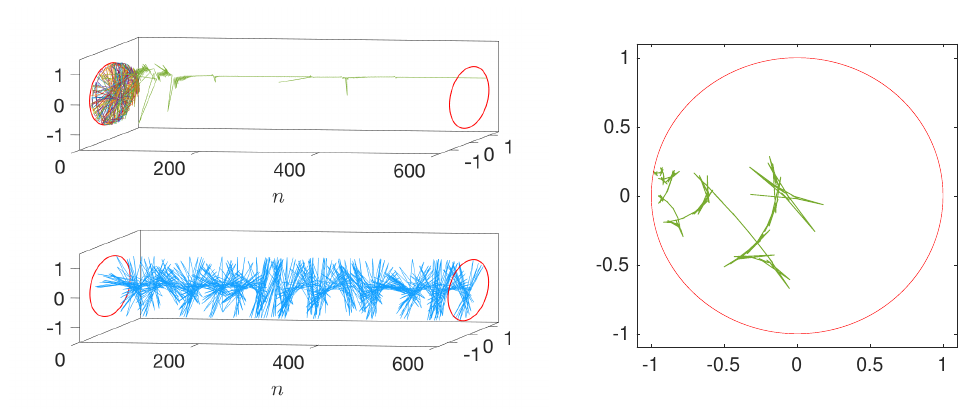
2 π xn Figure 22: Left (top): Trajectories of operator evolution ( e i l ) in a single random driving sequence. We choose 20 different initial positions homogeneously distributed 2 π x peak on the circle. Left (bottom): The trajectory of energy density peaks e i l in a = 0.01. The driving protocol and other single random sequence. We choose ∆ T / l eff parameters are the same as those in Fig. 7. Right: A sample plot of group walking of ρ in a randomly driven CFT. In the long time driving limit n → ∞ , ρ will approach a certain stable fixed point on ∂ (cid:68) exponentially